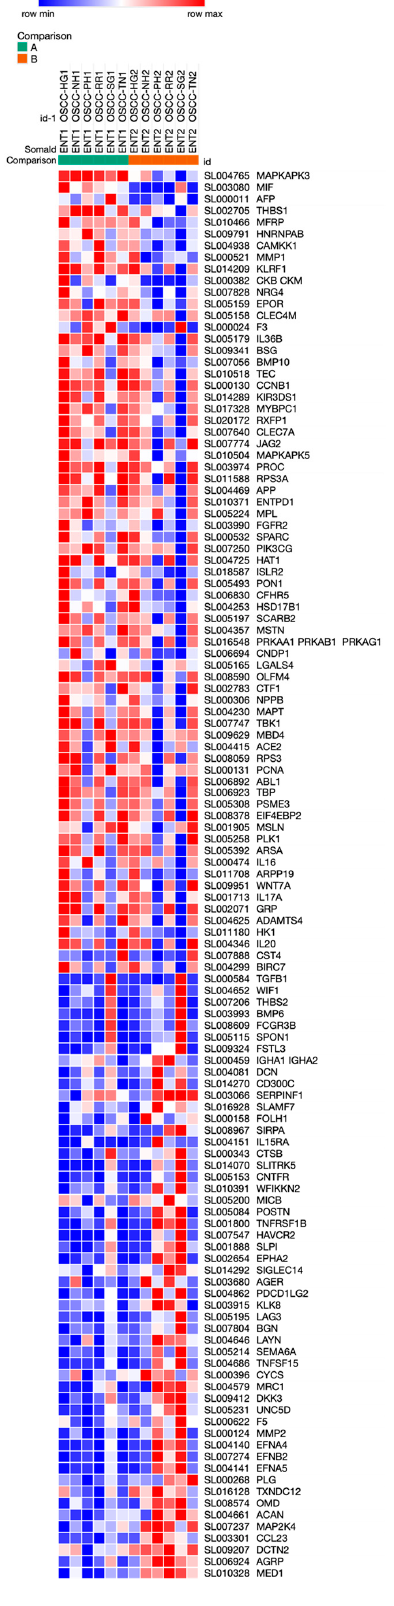
Figure 3. Heatmap of top 121 proteins discriminating between OSCC pre- ( left column) and post- resection ( right column, p < 0.05). Red = up-regulated, blue: down-regulated.